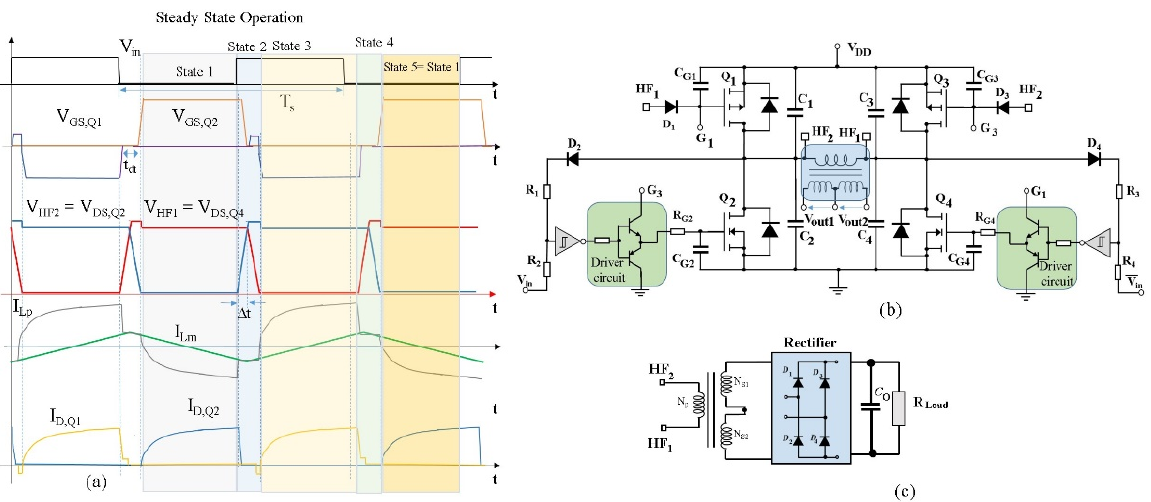
Figure 6. ( a ) Qualitative switching waveforms at steady state. ( b ) Schematic of full bridge based on complementary MOSFETs in switching leg. ( c ) Simplified transformer output circuit considered in the operation analysis.